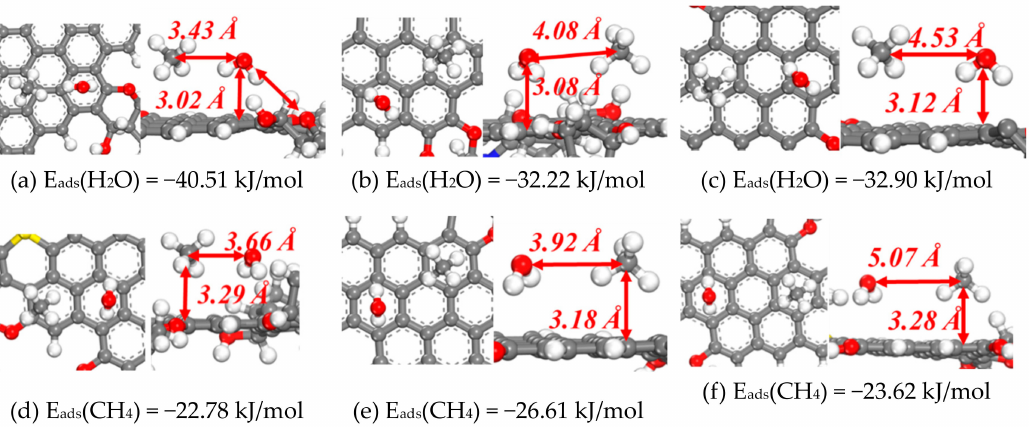
Figure 3. CH 4 and H 2 O co-adsorption geometries and energies. Panel ( a – c ) show di ff erent adsorption structures and energies of H 2 O with the presence of a CH 4 molecule. Panel ( d – f ) show the adsorption structures and energies of CH 4 with the presence of an H 2 O molecule. For each structure, a top view and a side view are given.